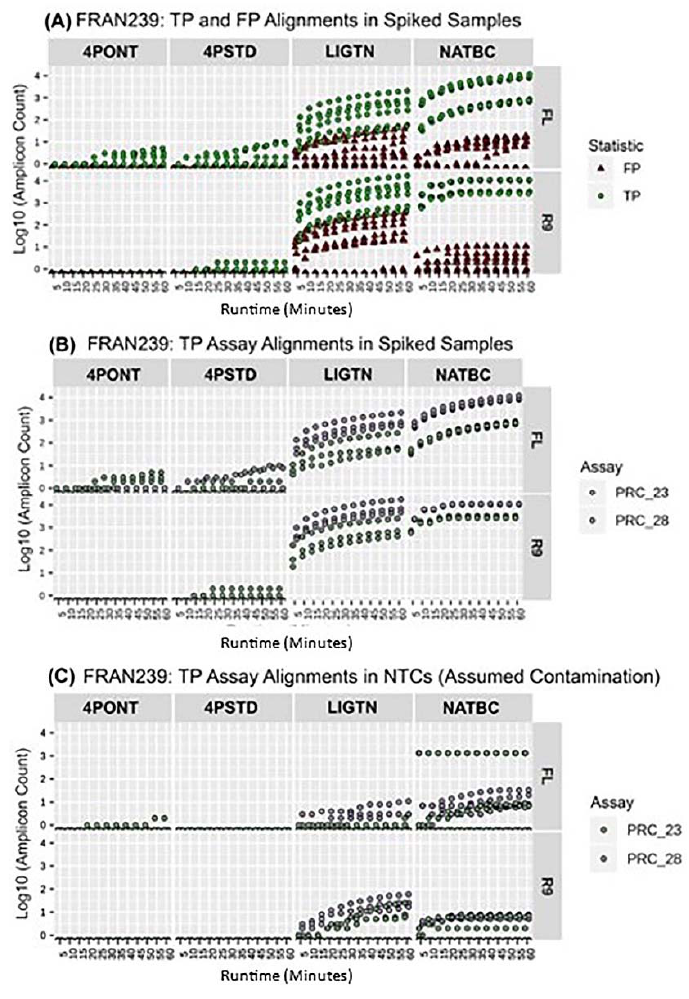
Figure 6. Temporal increases in read counts. The first hour of sequencing for each sample with spiked target-organism gDNA. The amplicon count (y-axis log10) corresponds to the read count of amplicon reference-aligned and filtered reads ( ≥ 90% identity and alignment length). The runtime of one hour is split at discrete 5 min intervals, with amplicon counts being a cumulative value from 5 to 60 min. Each method-flow cell type plot represents a sample in biological triplicate. Each replicate then may have amplicon counts for multiple amplicon assays. ( A ) TP and FP assay alignments among the triplicate samples are colored. Does not include NTCs. ( B ) Only TP assay alignments among the triplicate samples are shown and colored for discrimination. Does not include NTCs. ( C ) TP assay (specific to the spiked organism) alignments among all NTC samples.